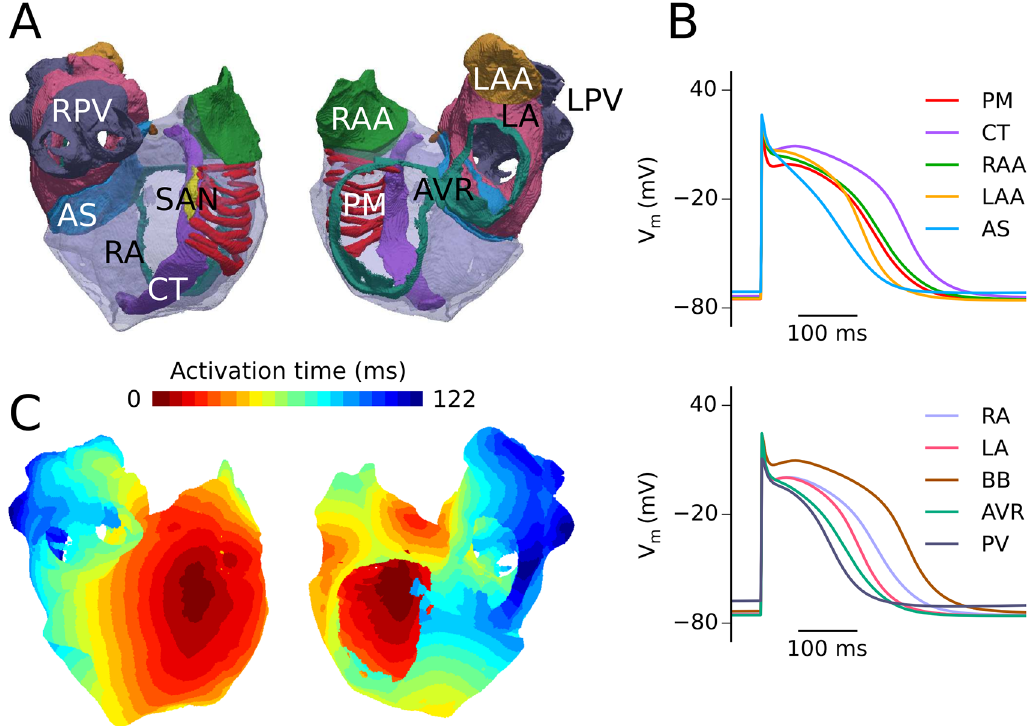
Fig 2. 3D anatomical atria model and regional APs. The anatomicalatria geometry shown from two views–looking at the RA posterior wall and into the cavities (A), with regionsof atrial septum (AS), atrio-ventricularring (AVR), crista terminalis(CT), left atrium (LA), left atrial appendage(LAA), left pulmonary veins (LPV), pectinatemuscles (PM), right atrium (RA), right atrial appendage (RAA), right pulmonary veins (RPV), and sinoatrialnode (SAN) shown for reference. Action potentials for regionalcell models includingthe Bachmann’s bundle(BB) at 1 Hz (B), with colours corresponding to tissue segmentation in (A). Activation sequencein the heterogeneous 3D anatomicalatria model, followinginitiation of an AP in the SAN